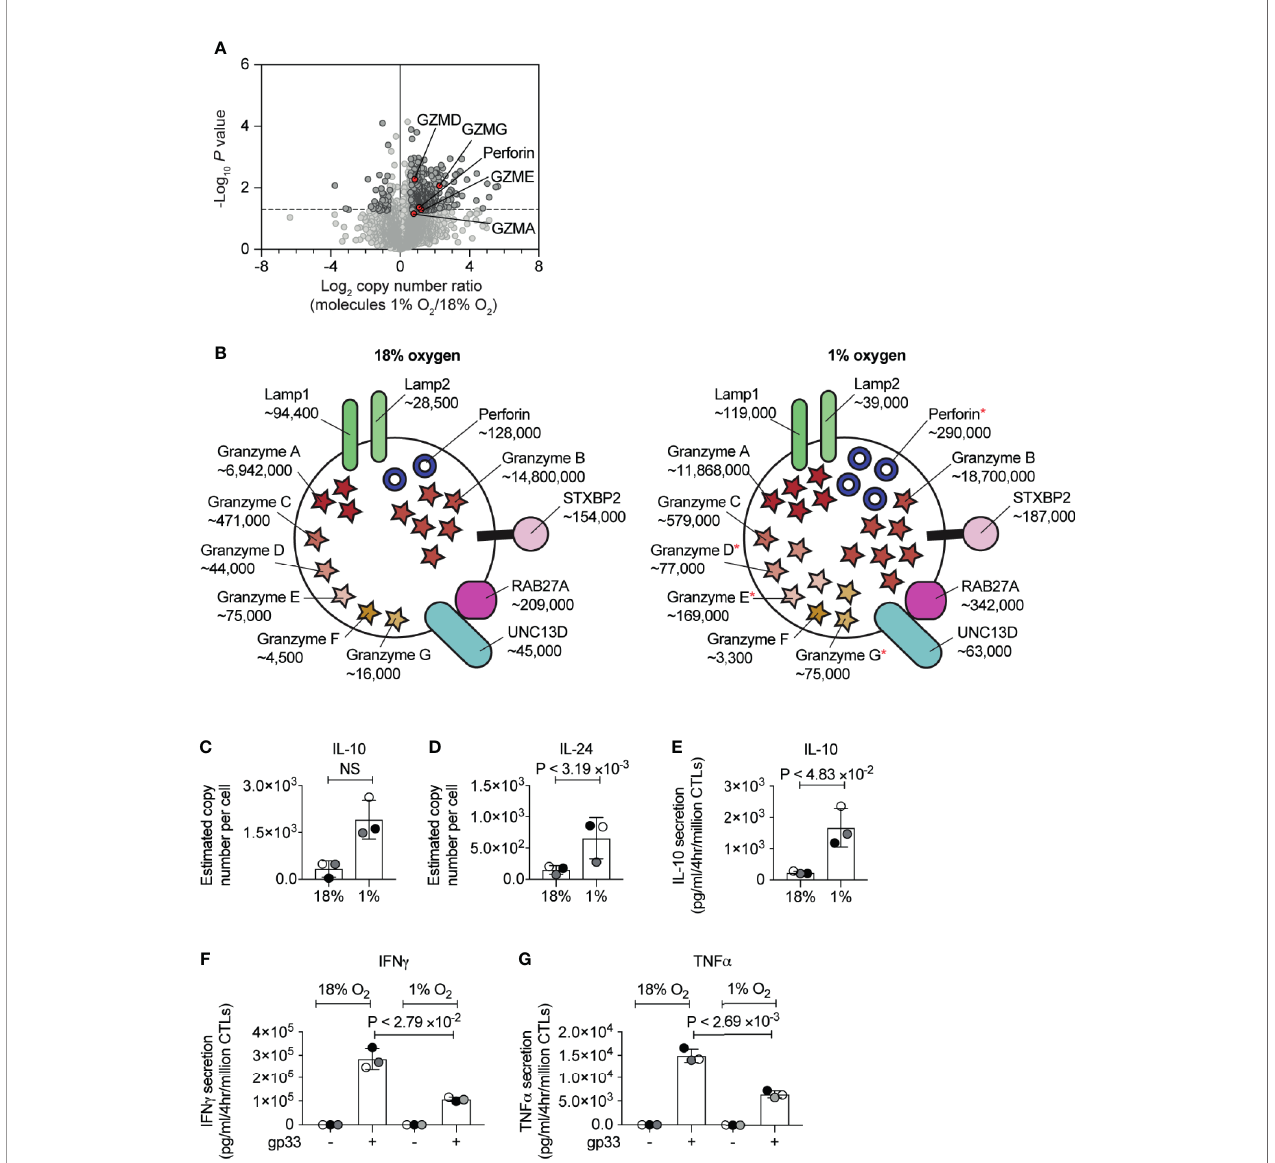
FIGURE 5 | The consequences of hypoxia on proteins involved in CTL cytolytic function. (A) Volcano plot showing the protein copy number ratio in CTLs subjected to 24 hours of hypoxia (1% O 2 ) compared to CTLs maintained in normoxia (18% O 2 ) with granzymes and perforin highlighted in red and annotated. (B) Schematic representation of secretory lysosomes showing cytolytic molecules and proteins required for degranulation. Average copy numbers for three biological replicates of CTLs maintained in normoxia or subjected to 24 hours of hypoxia are annotated alongside, with * indicating the proteins that increase signi fi cantly in abundance in hypoxia. (C, D) Copy numbers estimated from the proteomic data for IL-10 and IL-24. (E – G) CTLs were maintained in normoxia or subjected to hypoxia for 24 hours. Cytokine released by the CTLs was measured over a 4 hour period in normoxia or hypoxia. In (E) IL-10 was measured in unstimulated CTLs, and IFN g (F) and TNF a (G) were measured in unstimulated cells and cells stimulated with the gp33 peptide. Data in (A, C – G) show three biological replicates. Data in (B) show average values from three biological replicates. In bar charts, data points from each biological replicates are shown and colour matched, the bar shows the mean and the error bars show standard deviation. P values were calculated using a two-tailed paired t-test. Non-signi fi cant changes are marked